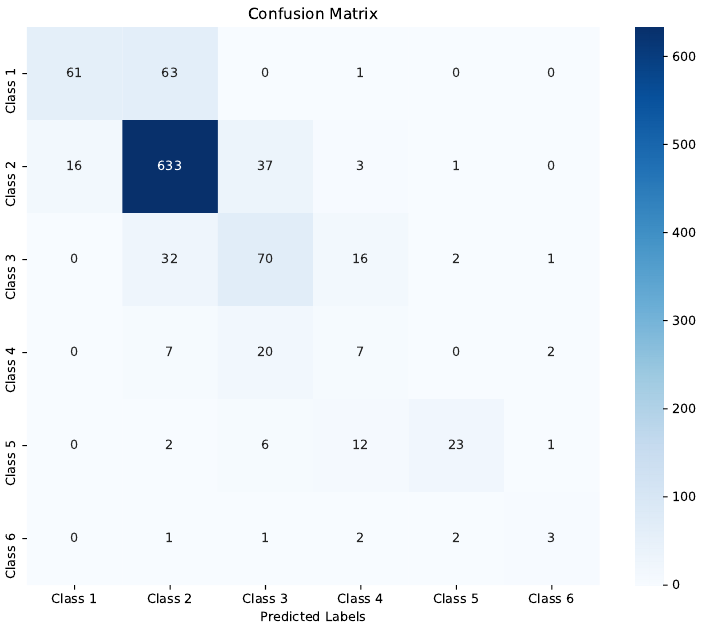
Figure 6. Confusion matrix results obtained for the IMAS with oversampling on the test